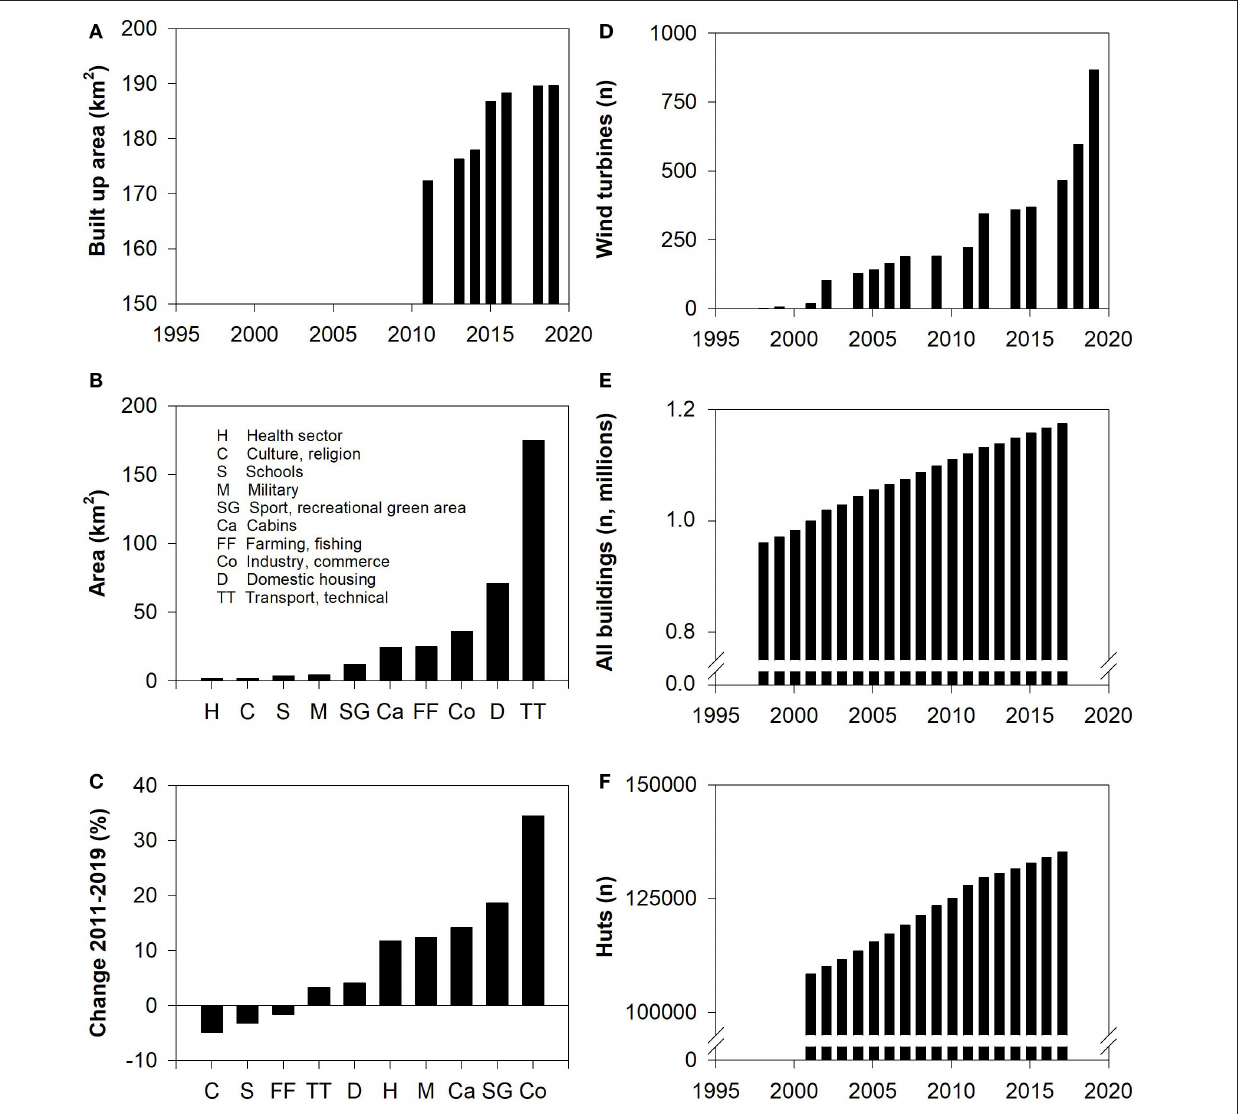
FIGURE 19 | Expansion of infrastructure since 1998 across the Saami reindeer husbandry area. (A) Total area of infrastructure (km 2 ) according to the categories shown in (B) . (B) Area of infrastructure (km 2 ) in 2019 by category. (C) Proportional change in the area of infrastructure (km 2 ) from 2011 to 2019 by category (%). (D) Number of wind turbines. (E) Number of buildings. (F) Number of recreational huts and summer houses (Norwegian: hytter og fritidsbolig ). (A–C) Data for the Troms, East and West Finnmark husbandry areas ( Figure 3 ); (D–F) data for the entire the Saami reindeer husbandry area. Sources: All data except (D) Statistics Norway; (D) Water Resources and Energy Directorate